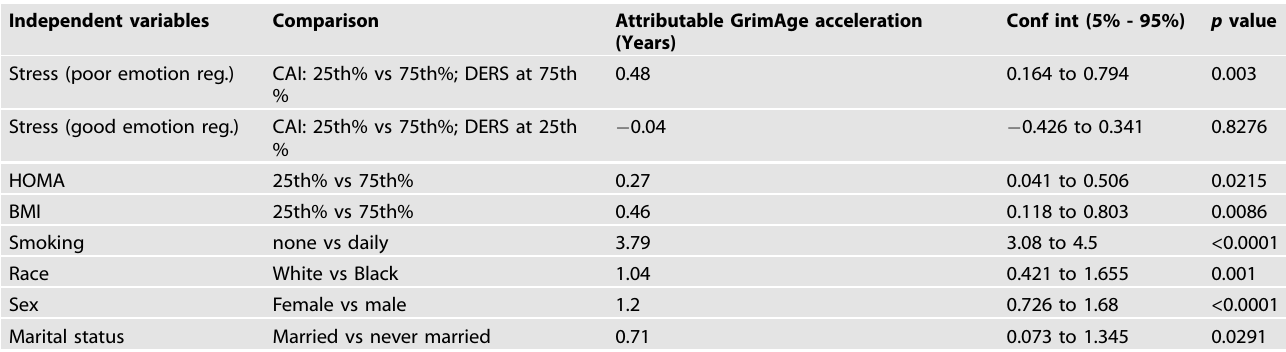
Analysis of estimated change in GrimAge (dependent variable) for different independent variables in the fi nal model. Comparisons for continuous variables are made between 25th percentile and 75th percentile, with a positive value signifying higher GrimAge in the 75th percentile. Categorical variables are compared as listed, with a positive value signifying higher GrimAge in the 2nd listed group. BMI body mass index, CAI cumulative adversity index, DERS dif fi culty with emotion regulation scale, HOMA homeostatic model assessment of insulin